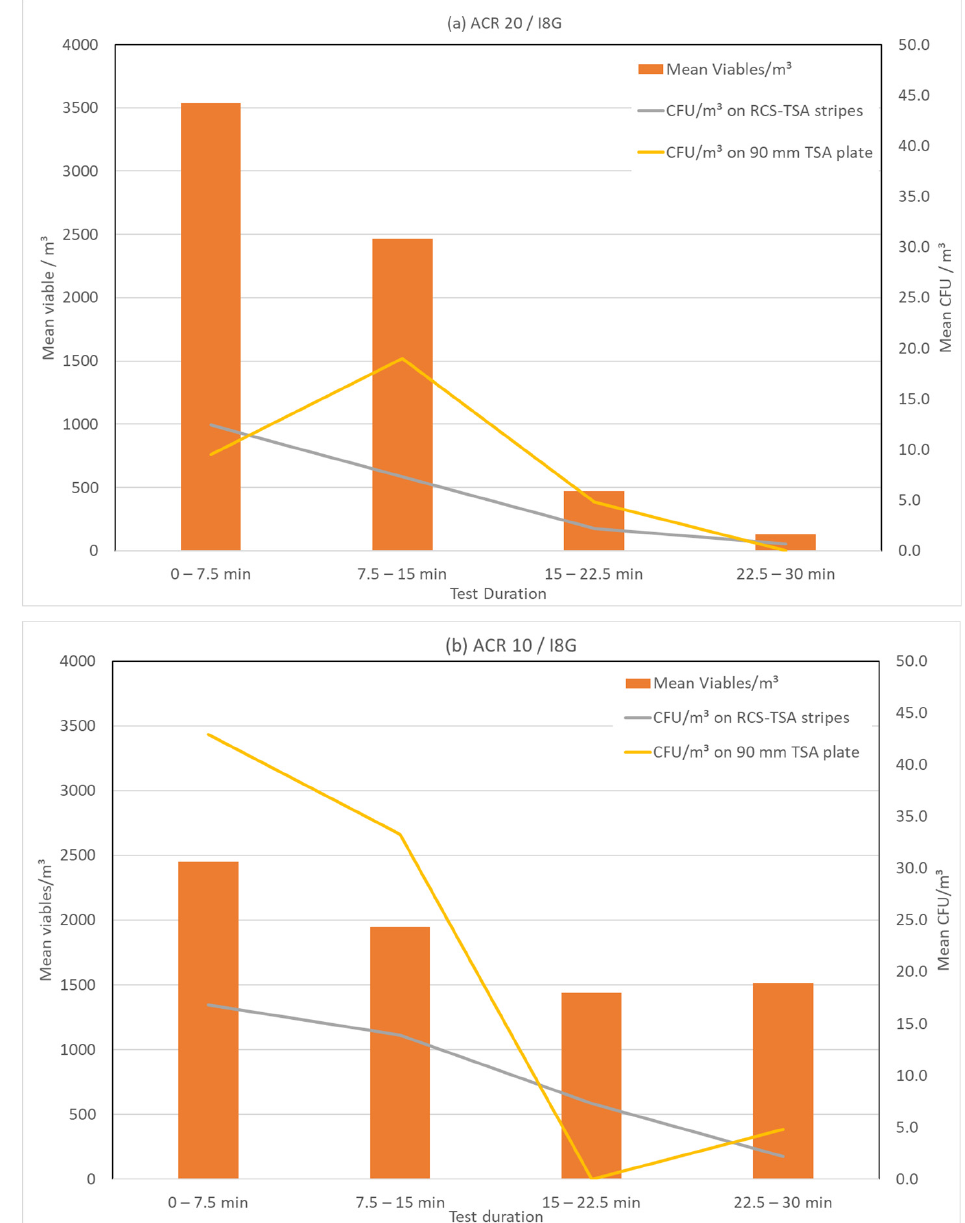
Figure 6. BFPC measured viables vs. CFUs with I8G: ( a ) at ACR 20/( b ) at ACR